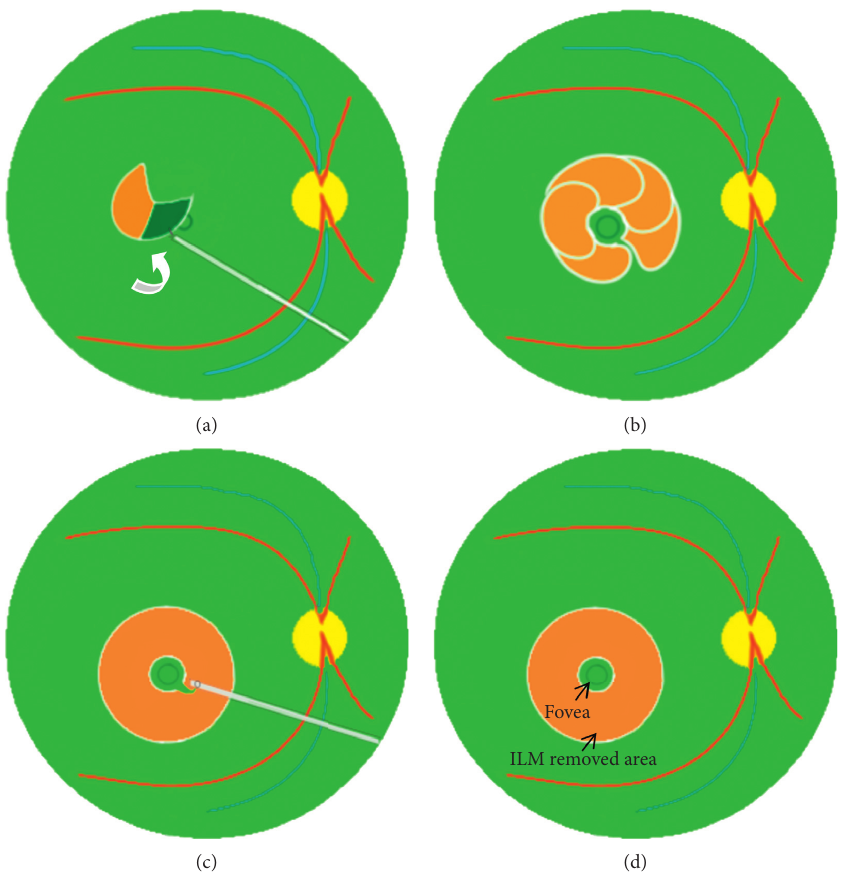
Figure 2: Schematic drawing of “arc-shaped foldback” fovea-sparing ILM peeling. (a) After ICG staining, initial ILM tear was performed away from the central fovea at the temporal side. The outer side of the ILM flap was grasped and moved from the outside to the paracentral fovea (white arrow), caution must be taken not to peel off the central foveal area. (b) The aforementioned operations were repeated, and all the ILM flaps were removed from the outside to paracentral fovea until a narrow strip of ILM remained. (c) The narrow strip of ILM was excised with a vitreous cutter. (d) The circular epifoveolar ILM was